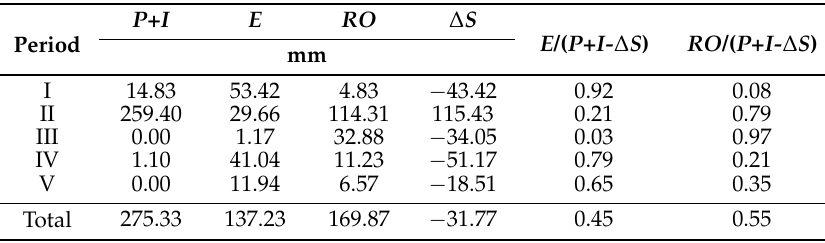
Table 6. Water balance check for different periods of soil FT.